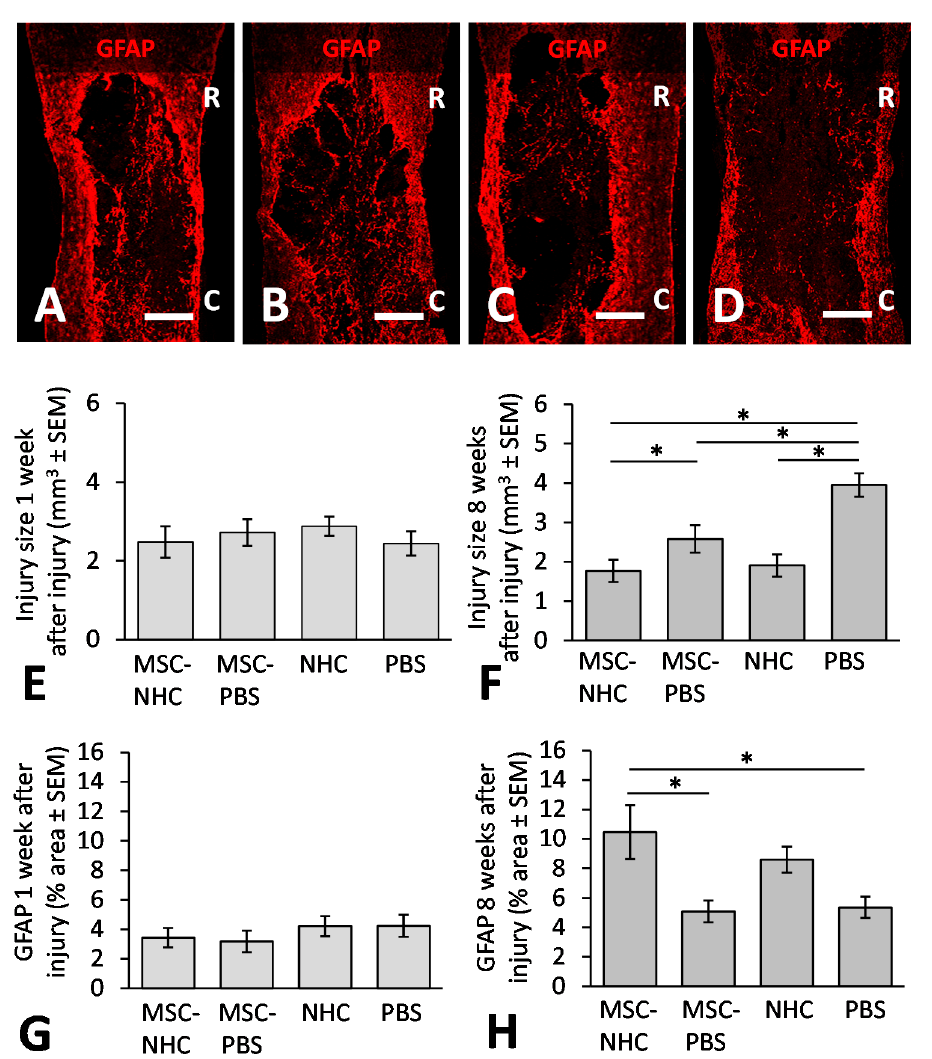
Figure 3. Injury size volume and astrocyte presence. Photomicrographs showing astrocytes stained for GFAP (red) in the injury site with MSC-NHC ( A ), MSC-PBS ( B ), NHC ( C ), or PBS ( D ) at 8 weeks after injury. The injury site was defined by the inner border of the GFAP+ scar. The scale bar in A is 600 µ m, and 550 µ m in ( B – D ). In ( A – D ), the rostral (R) and caudal (C) orientation of the horizontal sections are indicated. ( E ) Bar graph showing the volume of the injury site at 1 week after injury. There were no statistically significant differences between groups. ( F ) Bar graph showing the volume of the injury site at 8 weeks after injury. The injury site was significantly smaller with MSC-NHC compared with MSC-PBS or PBS only, with NHC compared with PBS, and with MSC-PBS compared with PBS only. ( G ) Bar graph of the percentage area of the injury site positive for GFAP at 1 week after injury. There were no statistically significant differences in astrocyte presence in the injury site between the groups. ( H ) Bar graph of the percentage area of the injury site positive for GFAP at 8 weeks after injury. There were significantly more astrocytes in the injury site with MSC-NHC compared with MSC-PBS and PBS only. In all graphs, the asterisks indicate p < 0.05, and the bars represent SEM. Abbreviations: GFAP = glial fibrillary acidic protein; MSC = mesenchymal stromal cells; NHC = nanofiber-hydrogel composite; PBS = phosphate-buffered saline; SEM = standard error of the